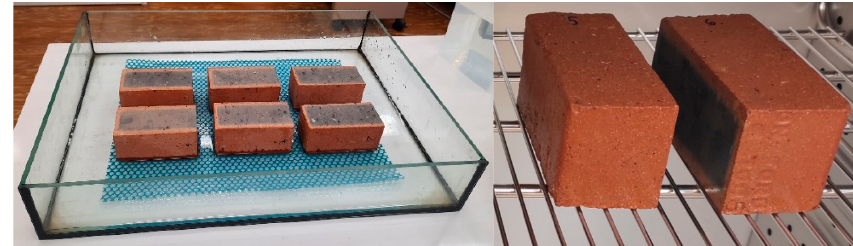
Figure 4. Sample conditioning in the authors’ freeze–thaw durability method.